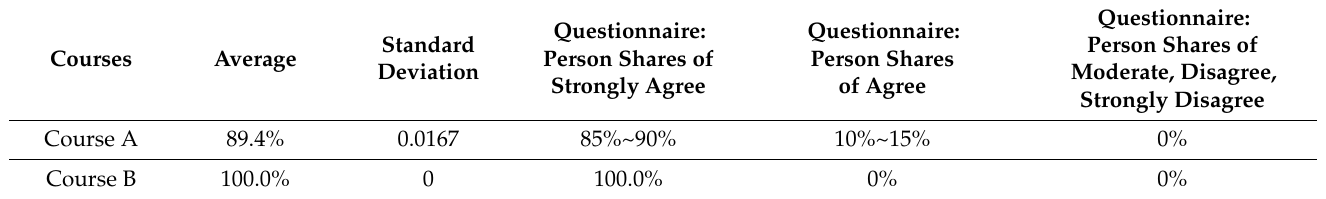
Table 6. The comparison between the two learning courses by person shares of strongly